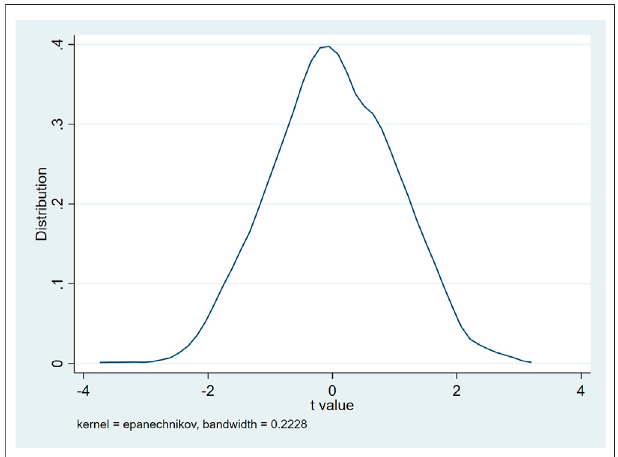
FIGURE 4 | Result of Kernel density